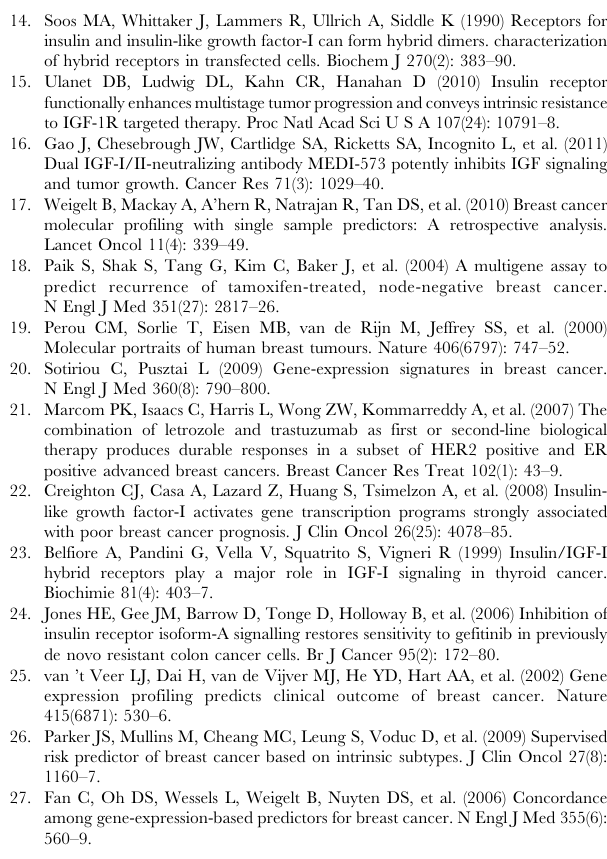
Table S1 Specificity of IR-A and IR-B assays. Assay specificity was tested by performing IR-A, IR-B, and IR qRT- PCR assays with a serial dilution of approximately 107 to 10 copies of plasmid DNA of IR-A and IR-B. Cross reactions of either IR-A assay to IR-B DNA or IR-B assay to IR-A DNA were not